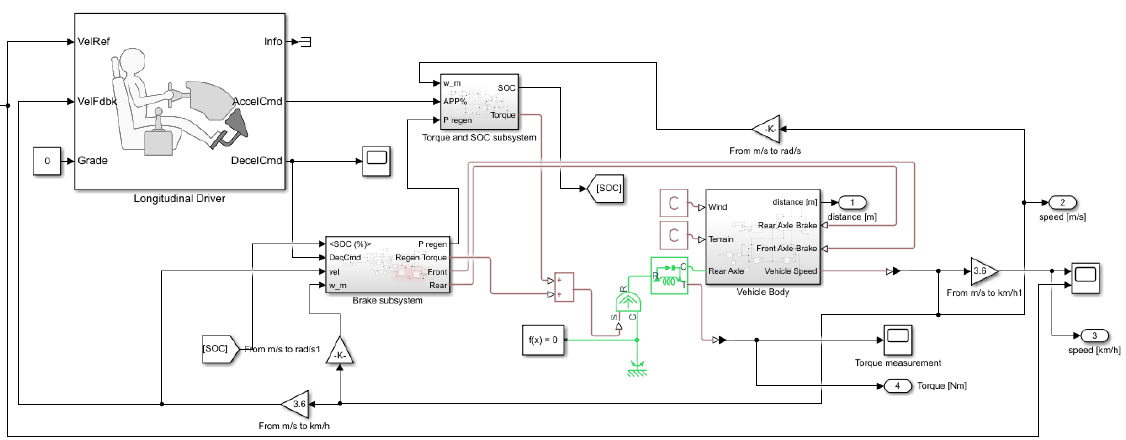
Figure 1. Battery Electric Vehicle implementation on Simulink ® .